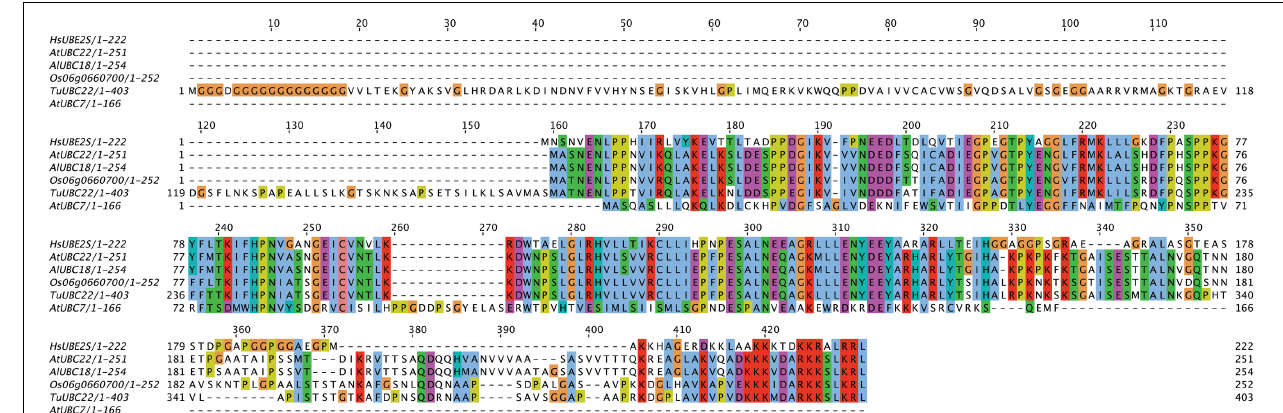
FIGURE 1 | Alignment of HsUBE2S with AtUBC22 homologs and AtUBC7. An alignment showing the amino acid sequence similarity between the K11-chain-formingHumanE2,UBE2S,theplanthomologsAtUBC22,AlUBC18, Os06g0660700, and TuUBC22, and the K48-chain-forming AtUBC7. The